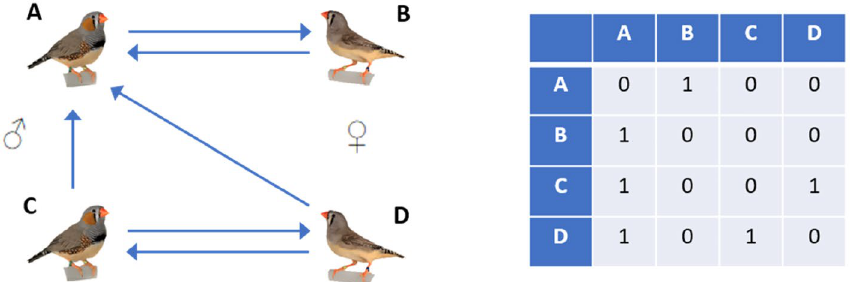
Figure 1. Left: schematic of a specific communication network among 4 zebra finches. In this example, the communication links within two male–female couples are symmetric, but only male A can hear the other couple. In other words, there are links from birds C and D to bird A but there is no link in the reverse direction. Right: this network can be represented as a binary 4-by-4 connection matrix in which the diagonal elements are zero and six off-diagonal elements are one.